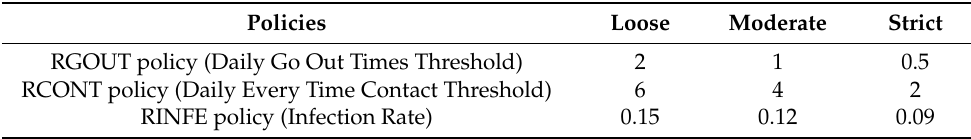
Table 1. Quantitative design strategies for prevention and control policies. Policies Loose Moderate Strict